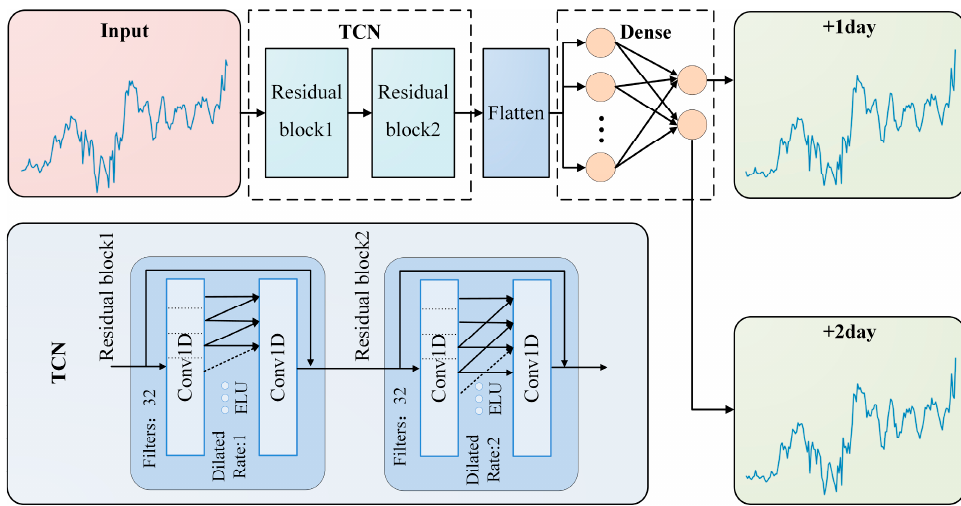
Figure 1. The overall architecture of the proposed model.